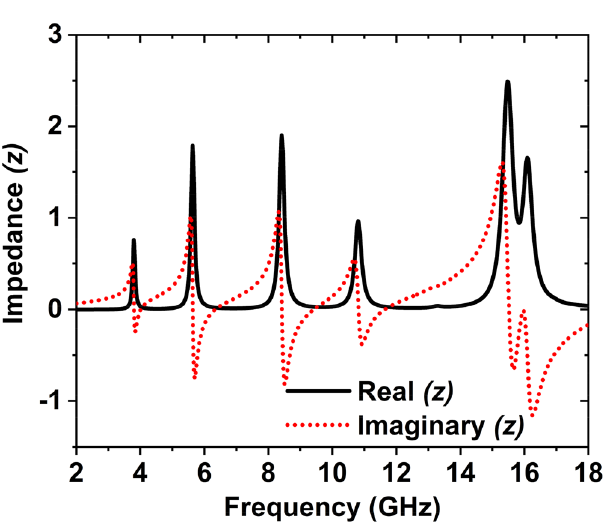
Figure 9. Normalized impedance of the MAA unit